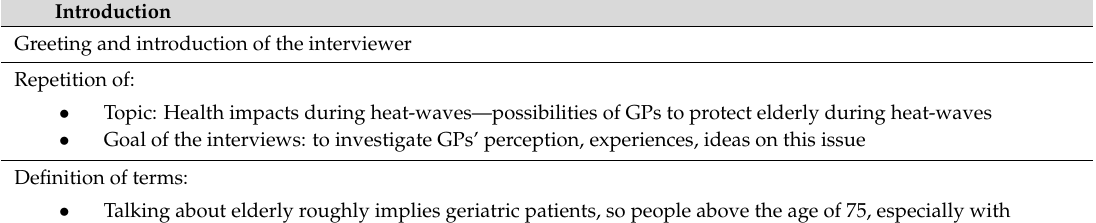
Table A1. Interview